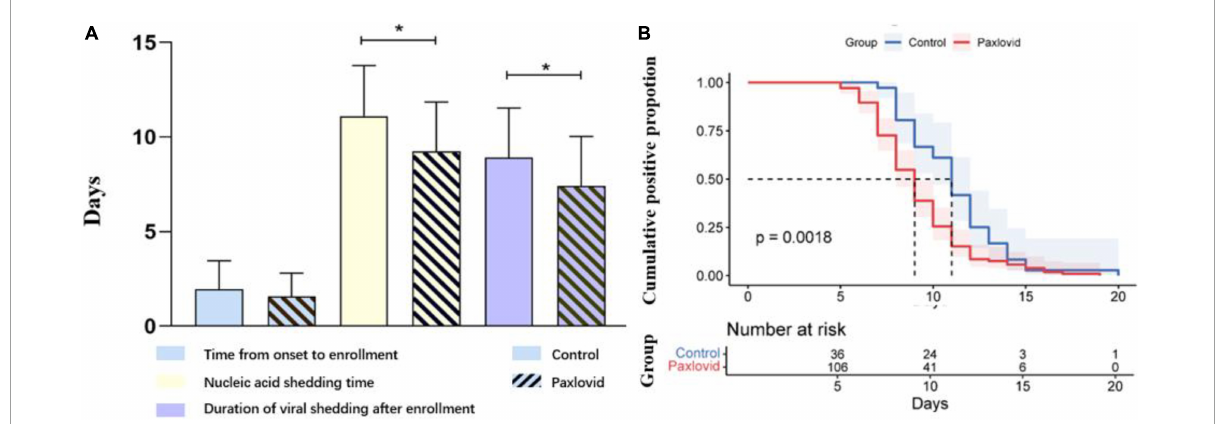
FIGURE1 (A) Paxlovid can significantly reduce the nucleic acid shedding time of patients. No significant difference was find in the time from onset to enrollment between control and paxlovid group. (B) The nucleic acid shedding time of patients was calculated by Kaplan-Meier method. Mean ± SD. *P <